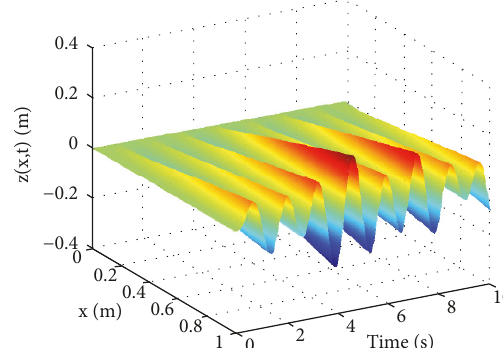
Figure 3: Deflection of the string with the proposed control.